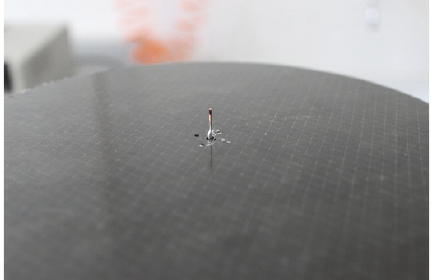
Figure 8: Monopole antenna for 5.9 GHz on a circular shred-CFRP ground plane.